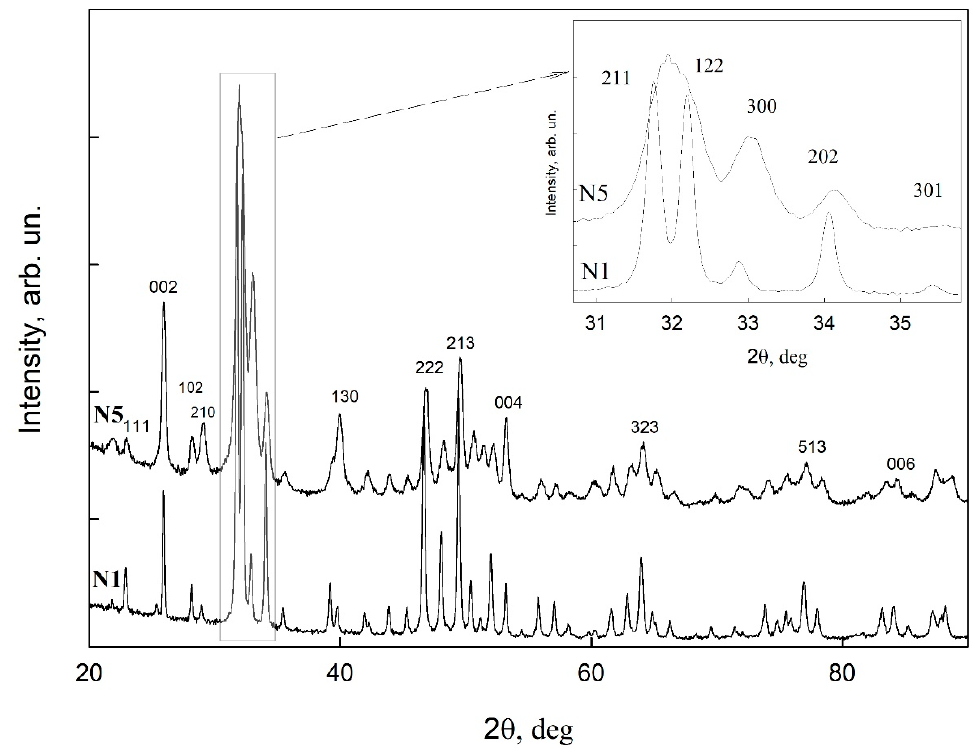
Figure 7. Results of XRD analysis of healthy tooth enamel without treatment (sample N1) and the sample with mineralized layer obtained after surface pretreatment with Ca(OH) 2 and an amino acid booster, with subsequent mineralization (sample N5).